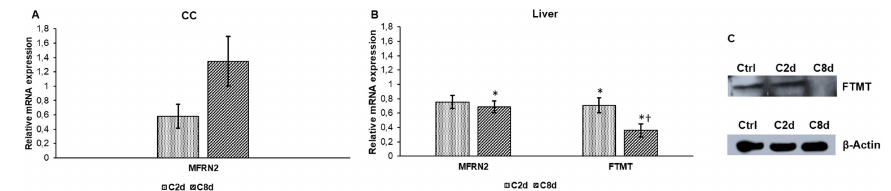
Figure 5. mRNA analyses of mitochondrial ferritin (FTMT) and mitoferrin-2 (MFRN2) genes in CC and in the liver and Western blot analysis of FTMT in the liver of CZ treated groups. Real Time PCR was performed with SYBR green protocol using gene specific primers. β -actin was used as housekeeping gene for the normalization and relative expression of controls was regarded as 1. Western blot analyses were made from protein extracts of the liver tissue samples. ( A ) Relative mRNA level of MFRN2 in CC. ( B ) Relative mRNA levels of FTMT and MFRN2 in the liver. ( C ) FTMT protein expression levels in the liver. The Western blot experiments were repeated at least three times in each group. The bars represent mean values and error bars represent standard errors of the mean (SEM) for three independent determinations. For statistical analyses, Student’s t -test and two-sample t -tests were used. The asterisk represents a di ff erence p < 0.05 compared to non-treated animals, while the cross indicates p < 0.05 between the treated groups, n = 6 in each group. Optical density analysis can be seen in Figure S1.